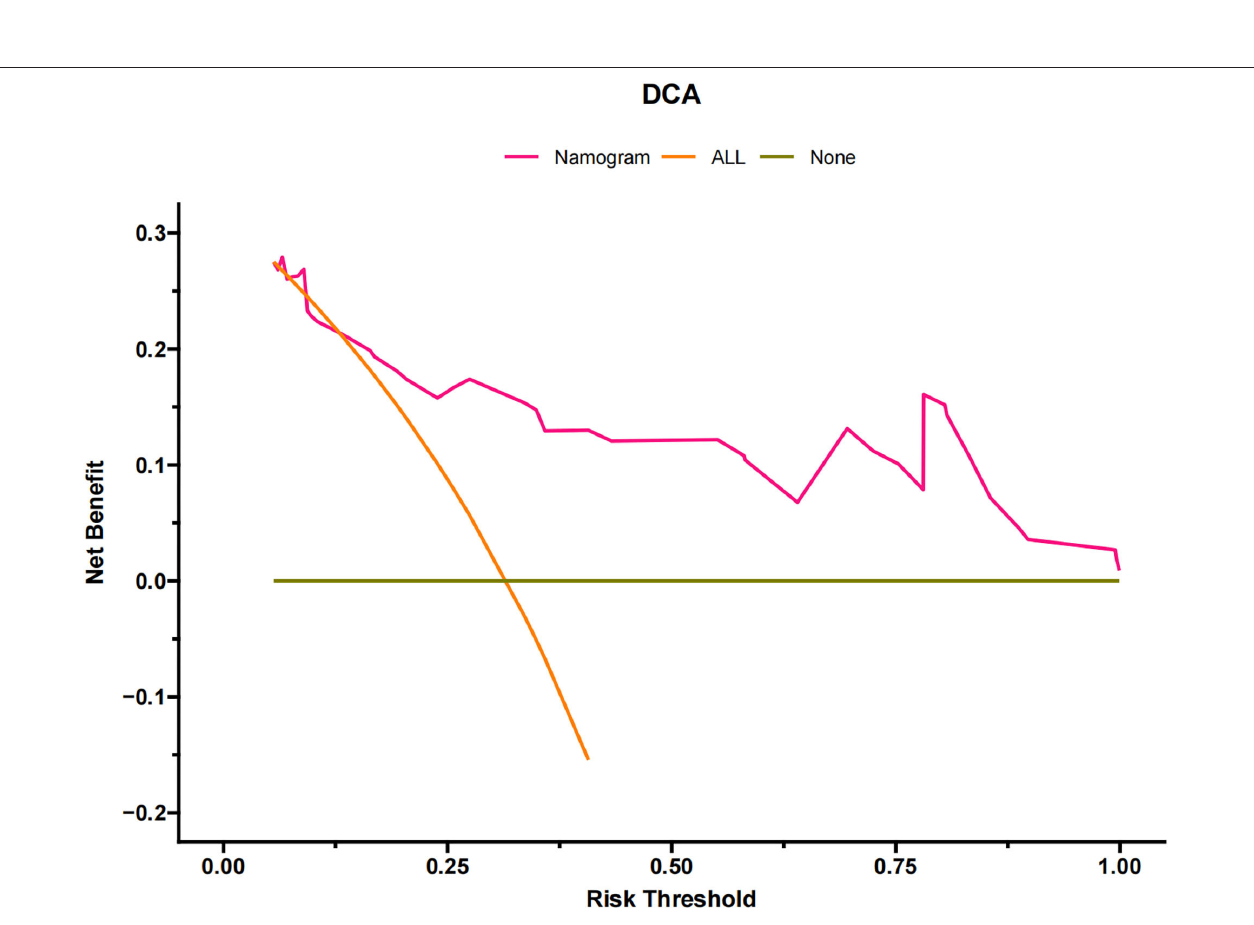
Frontiers in Public Health |